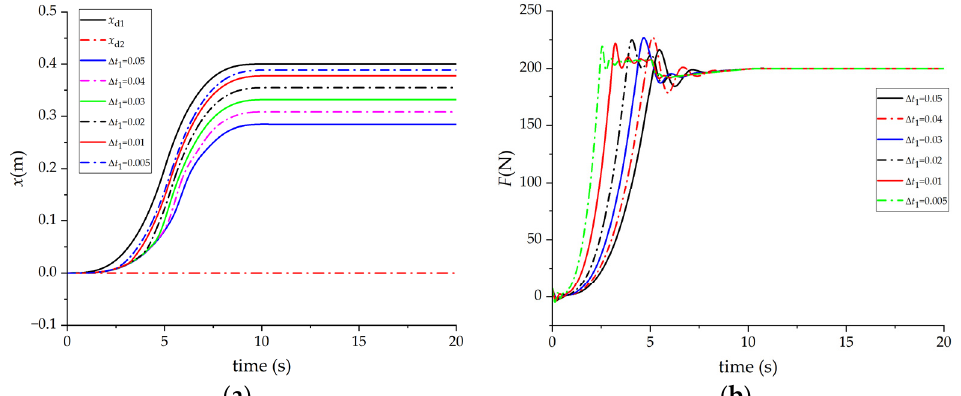
Δ t on the final position of the virtual object: ( a ) position profiles of Figure 14. The influence of Figure 14. The influence of ∆ t 1 on the final position of the virtual object: ( a ) position profiles of the 1